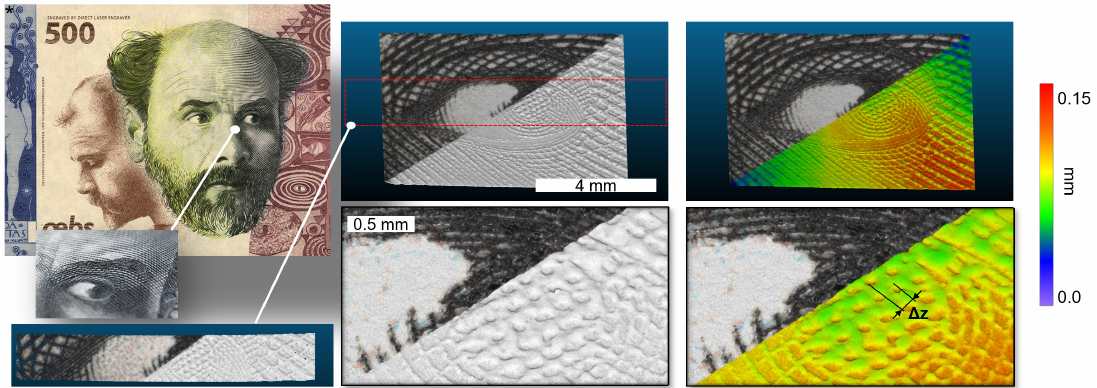
Figure 10. The results of our proposed microscopic imaging setup scanning a Klimt banknote provided by OEBS, with 7 stitched lanes, covering the whole eye. The intaglio print can by nicely seen on the eyeball at the depth measured to be 57 µ m. On the left lower side, the result of a single line acquired with 12 mm/s is shown, whereas the 7 lanes were acquired with 7